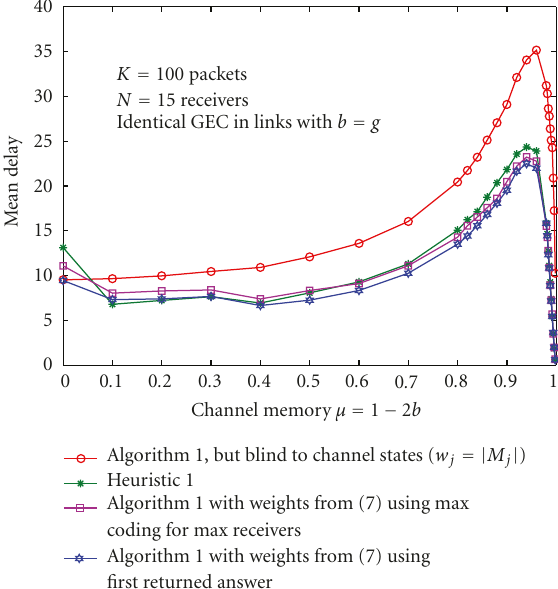
Figure 11: The e ff ect of post processing on mean delay. As explained in the main text, whenever Algorithm 1 returns multiple solutions, choosing the maximum amount of coding and serving maximum number of receivers can often have adverse e ff ects on the